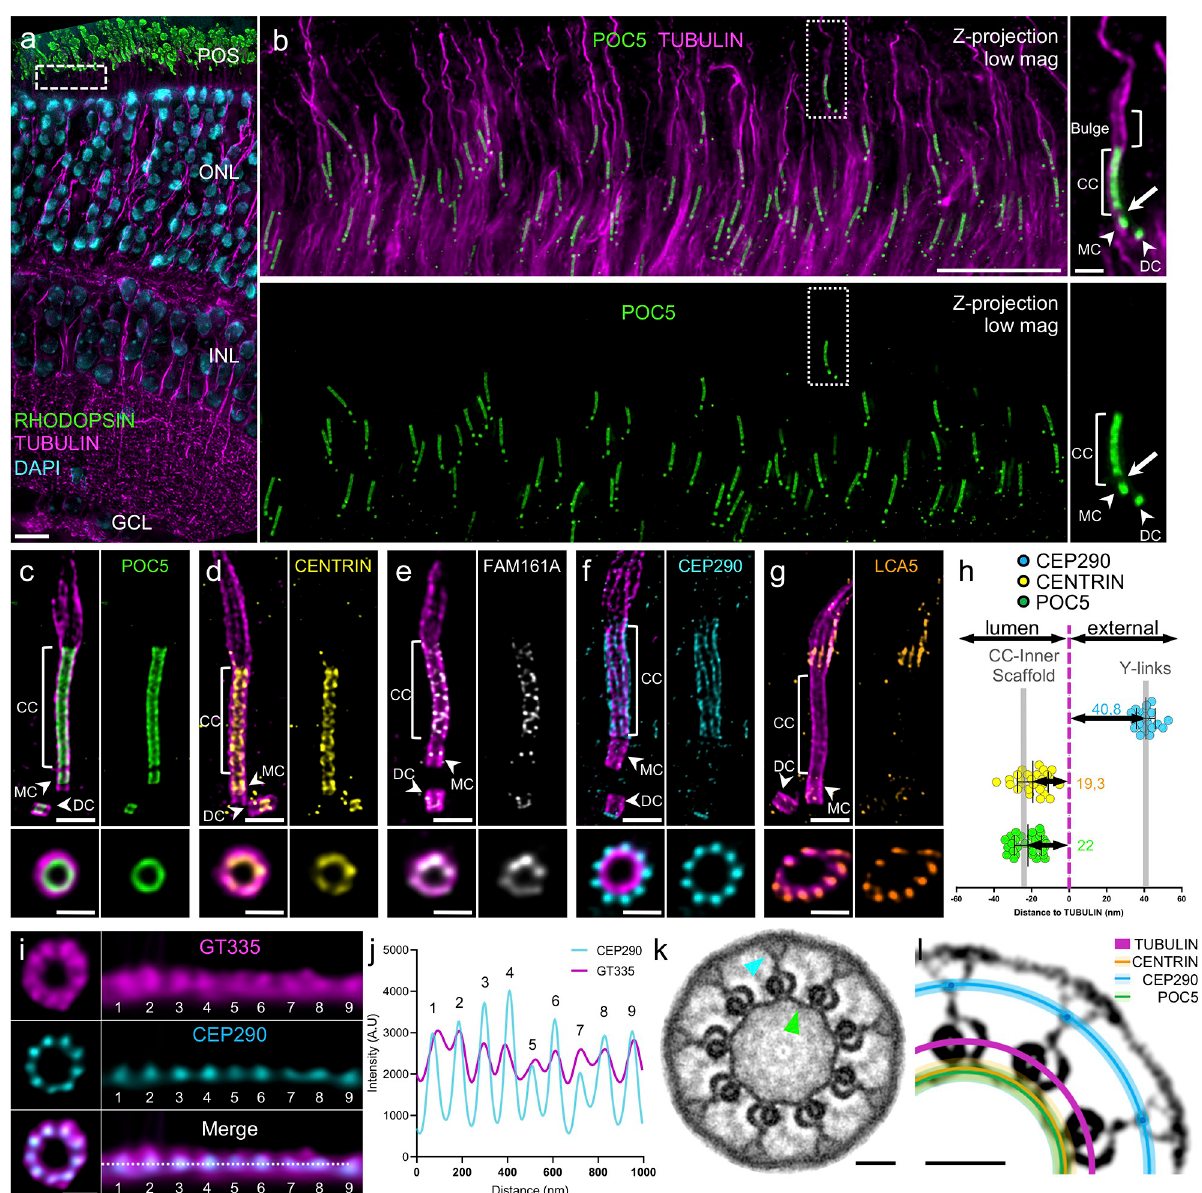
Fig 1. Molecular mapping of the mammalian photoreceptor connecting cilium. AU : AbbreviationlisthavebeencompiledforthoseusedinFigs 1 (cid:0) 5 andS 1 (cid:0) S 12 : Pleaseverifythatallentriesarecorrect : ( a ) Low magnification U-ExM image of a P14 mouse retina highlighting the preservation of the different retina layers. Note that the RPE layer is removed with the dissection. Scale bar: 10 μ m. ( b ) Expanded P14 photoreceptor layer (equivalent region to the white dashed line depicted in (a)). Inset shows details of 1 photoreceptor cell. Arrowheads indicate centrioles. Arrow depicts the gap between centriole and CC POC5 signals. Scale bar: 5 μ m (inset: 500 nm). ( c–g ) Confocal U-ExM images of adult photoreceptors stained for tubulin (magenta) and POC5 (c: green) or CENTRIN (d: yellow), FAM161A (e: gray), CEP290 (f: cyan), and LCA5 (g: orange). Lower panels show transversal views of the CC for each staining. Arrowheads indicate centrioles. Scale bars: side view = 500 nm; transversal view = 200 nm. ( h ) Distances between the maximum intensity of POC5 (green), CENTRIN (dark yellow), and CEP290 (cyan) compared to tubulin (magenta) calculated from transversal view images. Gray bars indicate the values obtained from the simulation in S4 Fig. n � 2 animals per staining. See S1 Table. ( i ) Transversal view (left) and polar transform (right) of GT335 (magenta) and CEP290 (cyan) signals revealing overlapping 9-fold symmetry. Scale bar: 200 nm. ( j ) Plot profiles of CEP290 (cyan) and GT335 (magenta) polar transform of (i). ( k ) Symmetrized EM image of a P14 CC transversal section revealing an inner ring decorating MTDs (green arrowhead) and Y-links bridging MTDs to the membrane (blue arrowhead). Scale bar: 50 nm. ( l ) Model representing relative positions calculated in (h) and (j) of POC5 (green line), CENTRIN (dark yellow line), CEP290 (cyan dot and line) to tubulin (magenta) on a contrasted symmetrized EM picture of a CC. Light color lines represent the SD for each protein. Scale bar: 50 nm. The data underlying all the graphs shown in the figure are included in the S1 Data file. CC, connecting cilium; DC, daughter centriole; GCL, ganglion cells layer; IPL, inner nuclear layer; MC, mother centriole; MTD, microtubule doublet; ONL, outer nuclear layer; POS, photoreceptor outer segment.